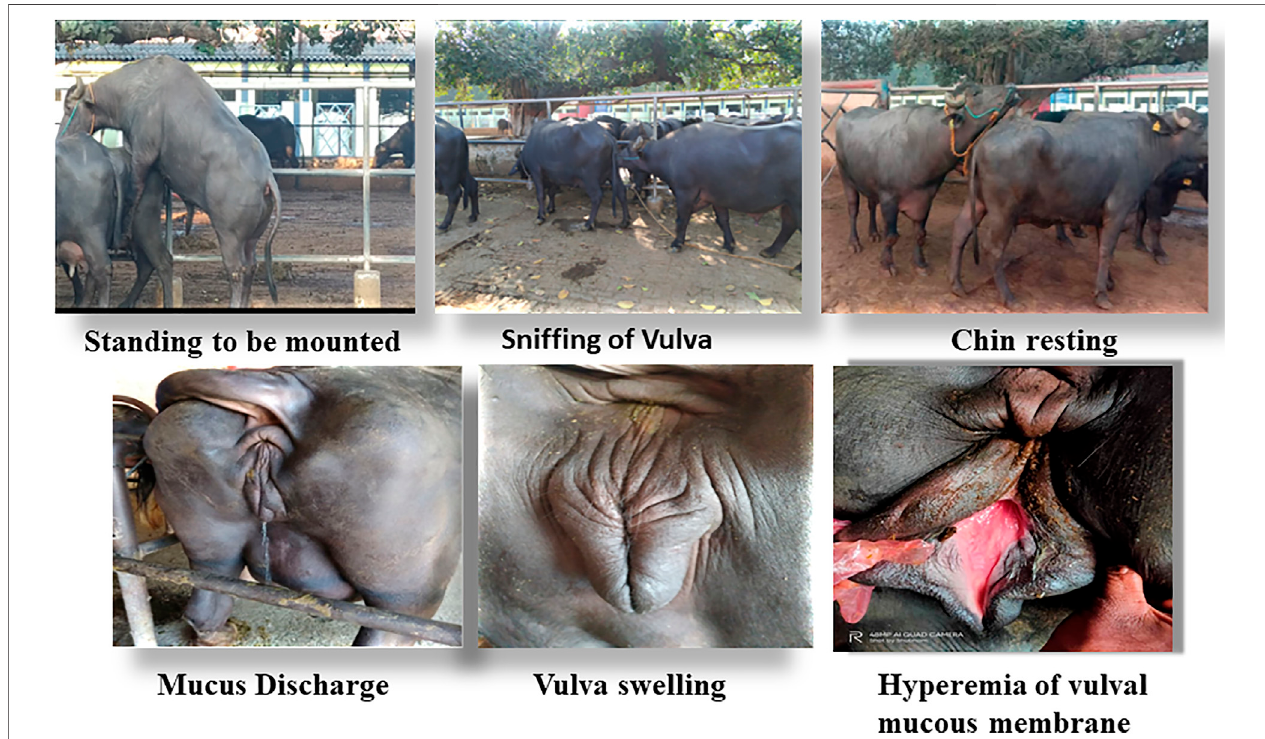
FIGURE 1 | Behavioral signs of estrus in